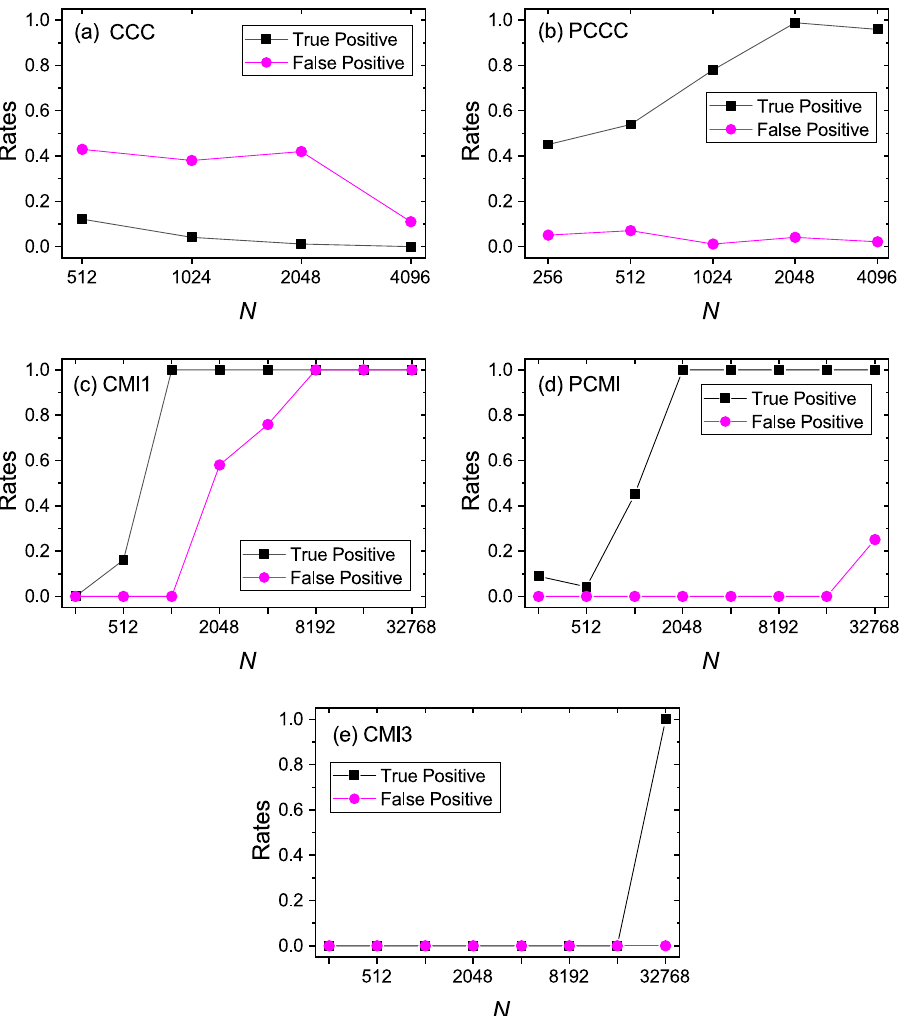
Figure 1. Specificity and sensitivity of methods with varying length. True positive rate (or rate of significant causality estimated from x 1 → x 2 ) and false positive rate (or rate of significant causality estimated from x 2 → x 1 ), using measures ( a ) scalar CCC (CCC), ( b ) permutation CCC (PCCC), ( c ) scalar CMI (CMI1), ( d ) permutation CMI (PCMI) and ( e ) three-dimensional CMI (CMI3), as the length of time series, N , is